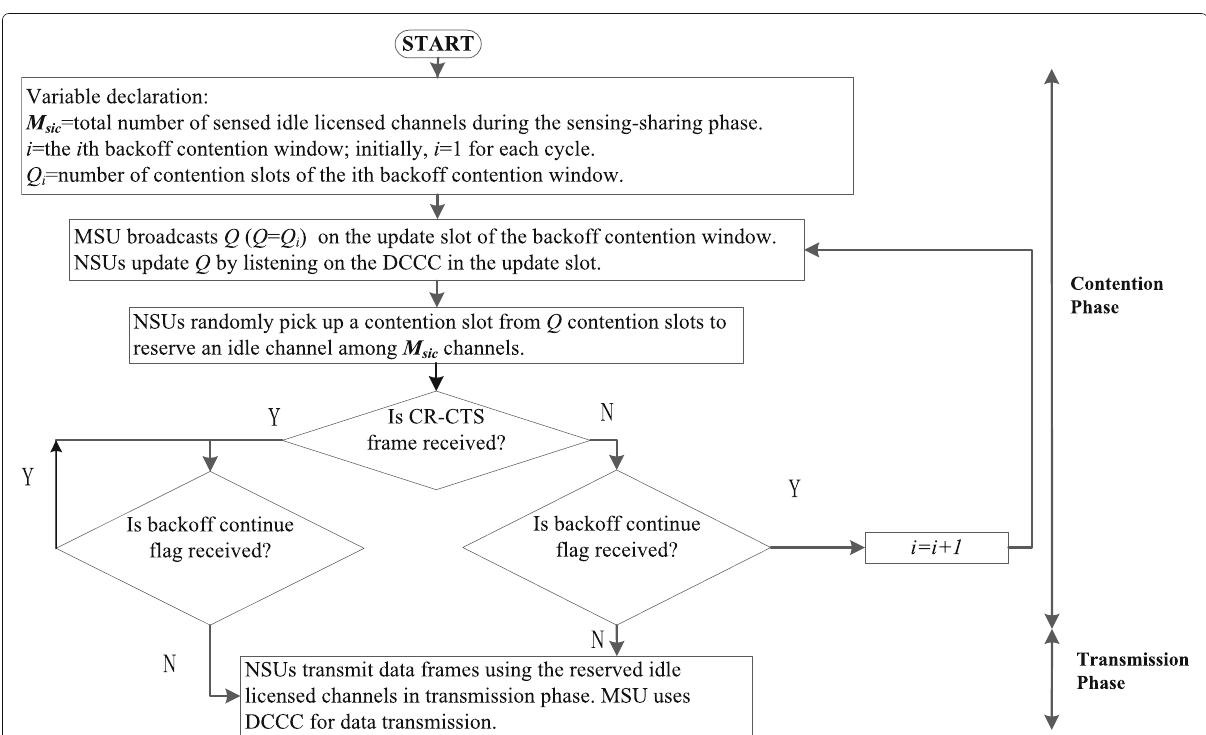
Fig. 3 Flow chart of the contention phase and transmission phase of the proposed MAC protocol. To show the operation details of the contention phase and transmission phase satisfactory system performance by using a fixed Q 1 , espe-